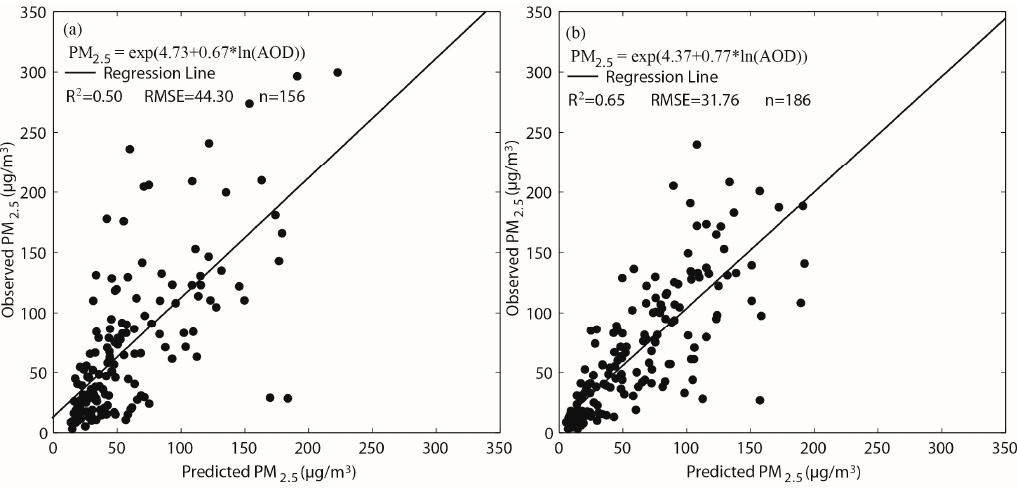
Figure 6. Scatter plots of the observed vs. the predicted surface PM 2.5 concentrations for the M-I-Sta ( a ) and the M-I-Con ( b ).